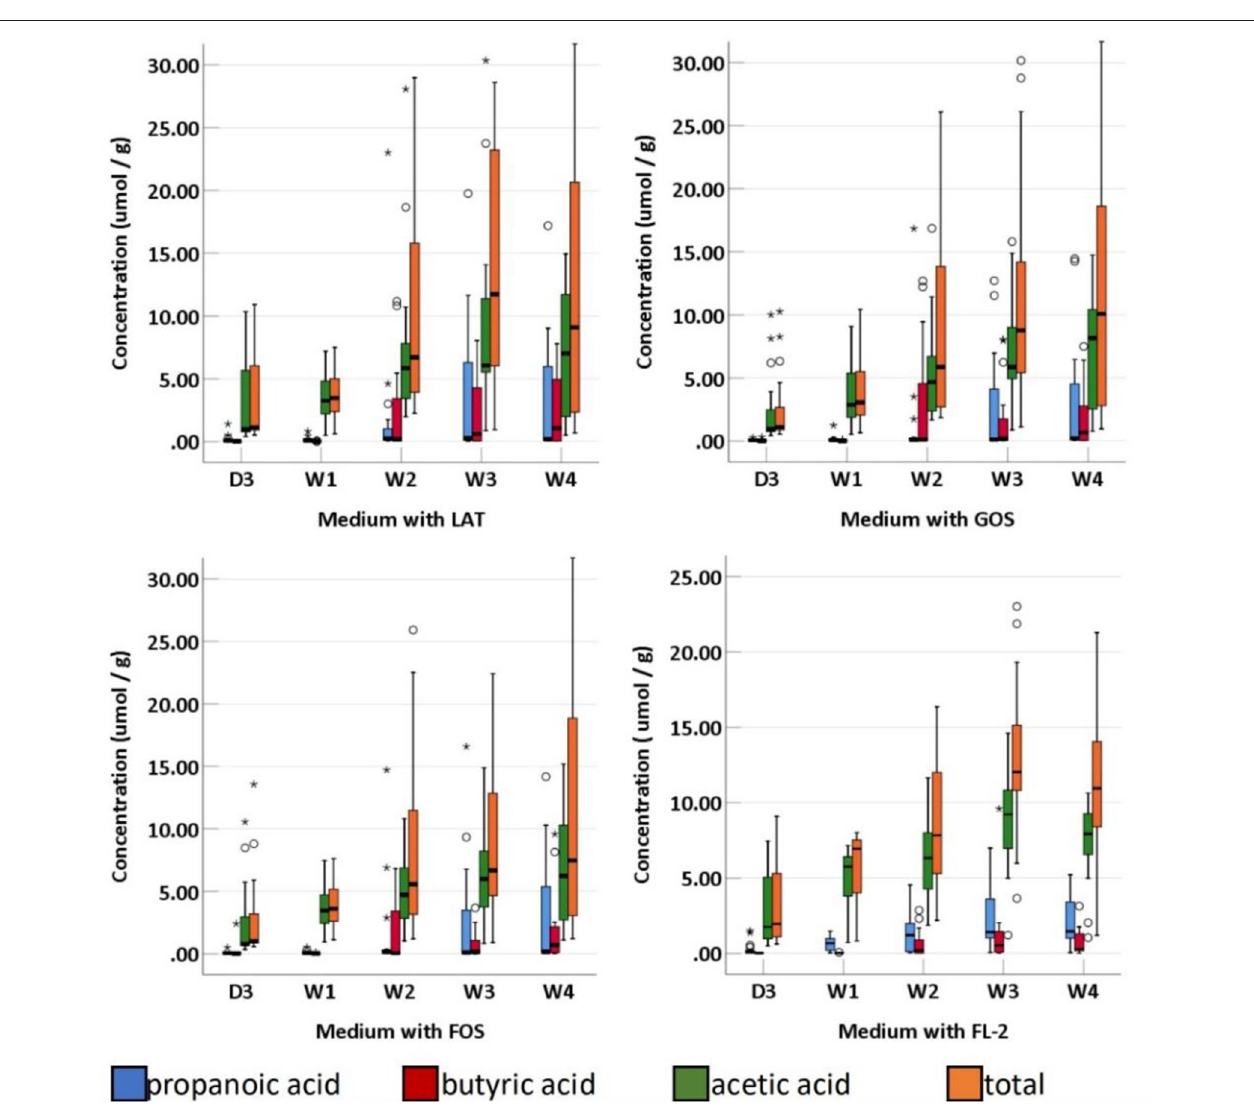
FIGURE 5 | The concentration of fecal SCFAs (propanoic acid, butyric acid, acetic acid, and total) of preterm infants of different ages. D3, 3 days after birth; W1, 1 Week after birth; W2, 2 weeks after birth; W3, 3 weeks after birth; W4, 4 weeks after birth; LAT, lactose; FOS, fructooligosaccharide; FL-2, milk oligosaccharide; GOS, galactooligosaccharide; *, extreme value; ◦ , discrete value; SCFAs, short-chain fatty acids.